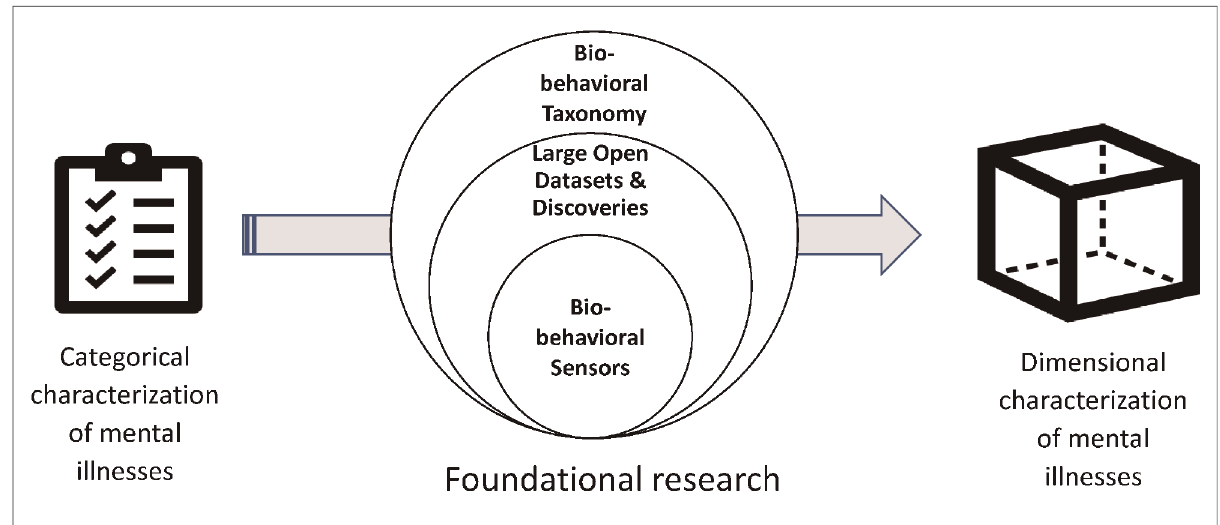
FIGURE 2 The role of big data in understanding mental health